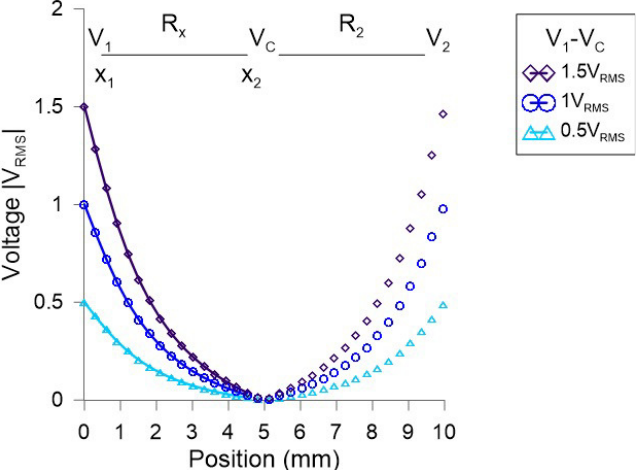
Figure 8. Simulation of the voltage distribution across the parabola-shaped transmission line for orthogonal configuration. Dots are the numerical estimations and lines the results of Equation